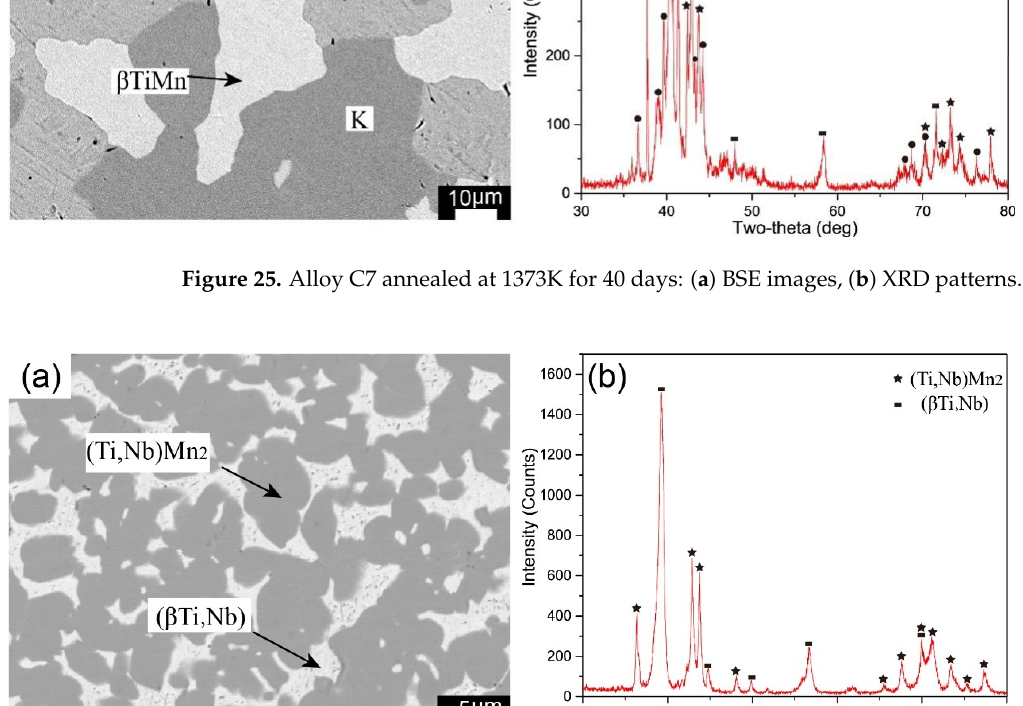
Figure 26. Alloy C3 annealed at 1373K for 40 days: ( a ) BSE images, ( b ) XRD patterns.